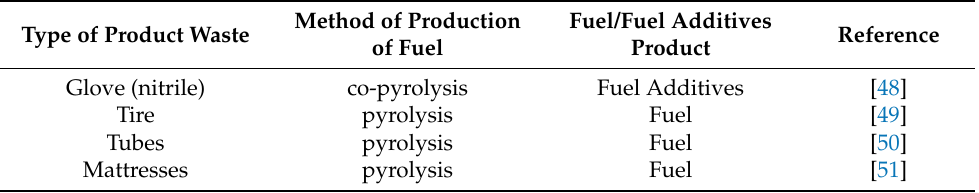
Table 2. Various synthesis methods of fuel from rubber